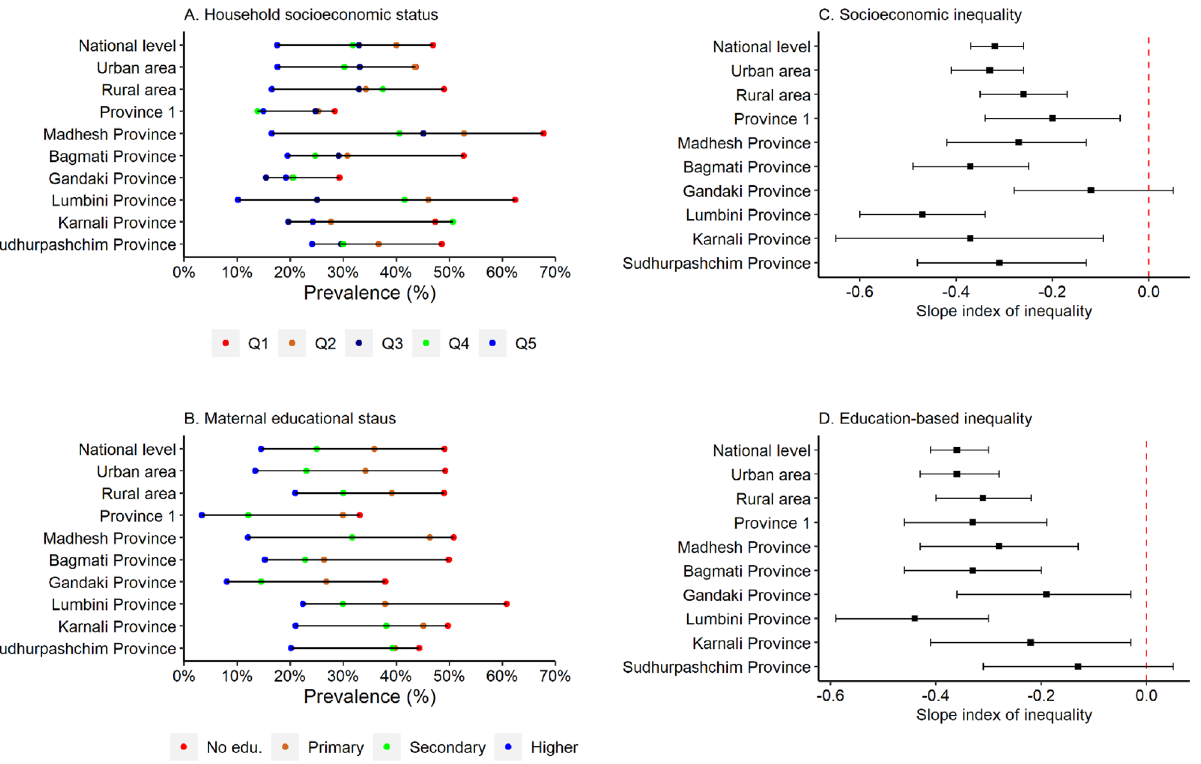
Figure 1. Prevalence of suspected developmental delays and level of absolute inequality among Nepalese children aged 3–4 years by household socioeconomic status and maternal